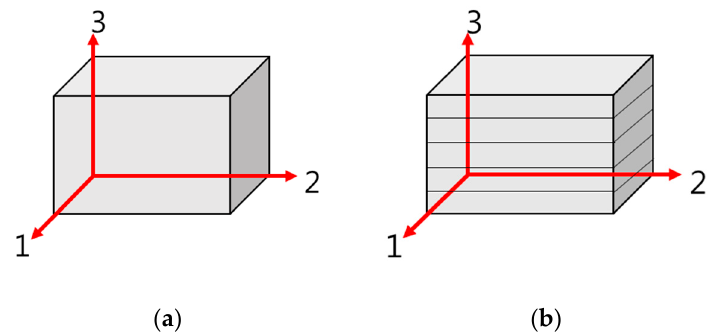
Figure 2. Normal concrete (homogeneous material) and 3D printed concrete (orthotropic material): ( a ) homogeneous material; and ( b ) orthotropic material.